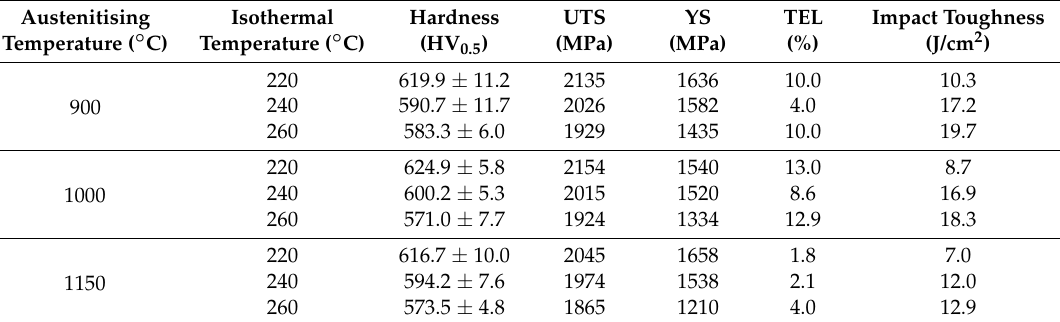
Table 1. Results of mechanical properties of samples isothermally transformed. TEL: total elongation; UTS: ultimate tensile strength; YS: yield strength.